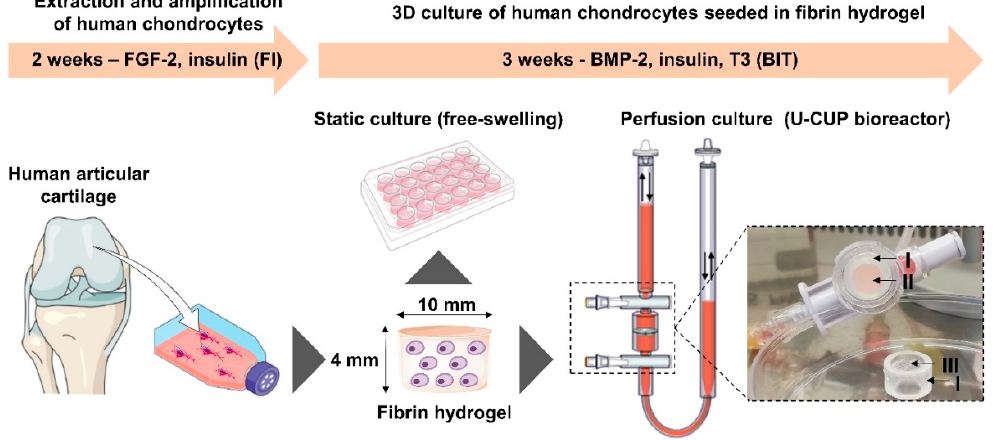
Figure 1. Scheme of the in vitro study and perfusion chamber. HACs were extracted from macroscopically healthy zones of knee cartilage and amplified for 2 weeks in monolayer with FGF-2 and insulin (FI) in the presence of 10% FBS. Cells were then seeded in fibrin hydrogel and cultured in the presence of BMP-2, insulin and T3 (BIT) in a well plate (static control) or a bidirectional perfusion bioreactor for 3 weeks. The perfusion chamber of the bioreactor was composed of (I) two silicone adaptors holding (II) the cartilage construct placed in between (III) two synthetic meshes.